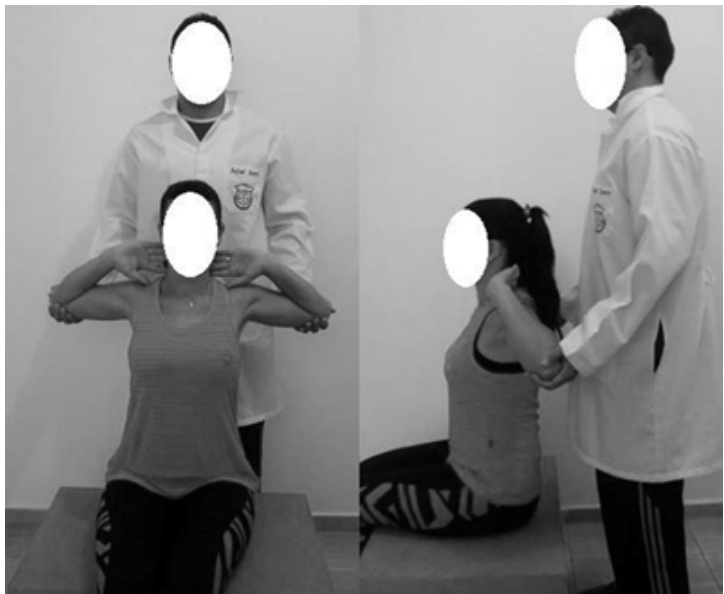
Figure 2. Stretching exercise for the shoulder